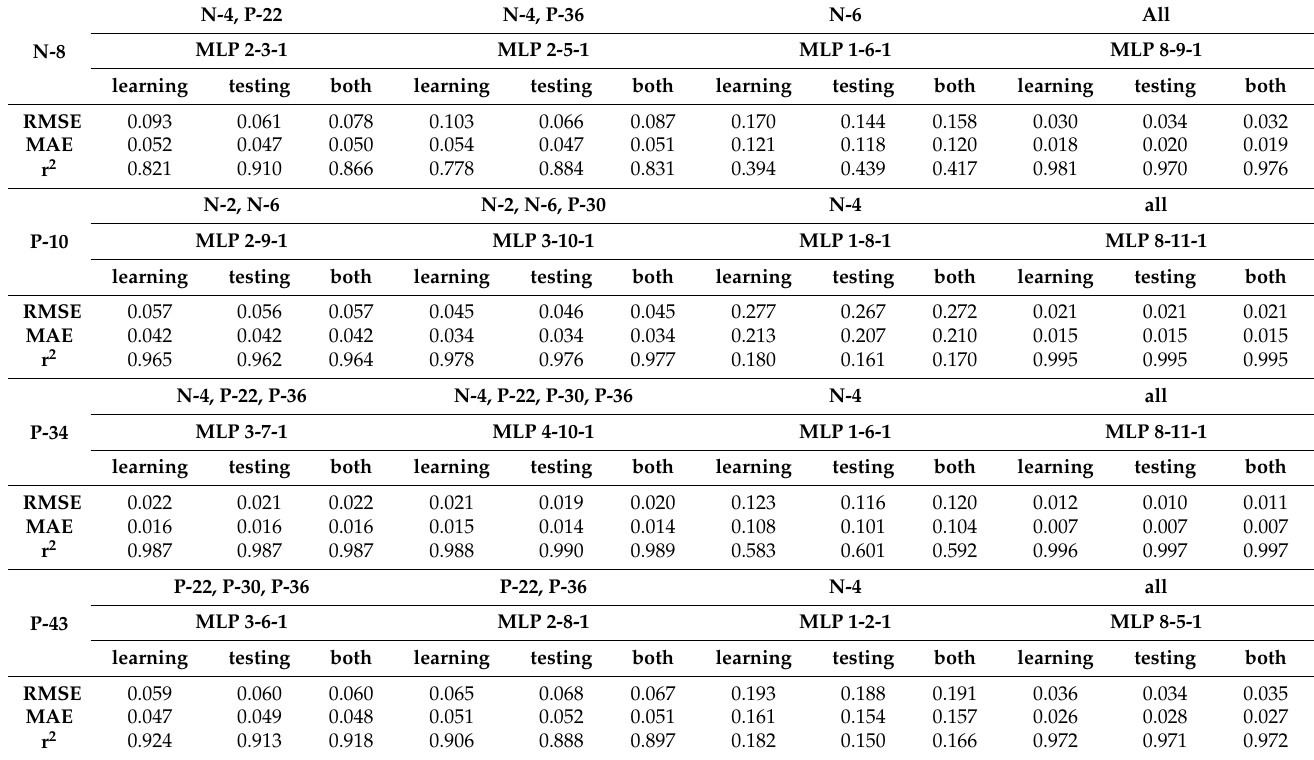
Table 4. ANN modelling